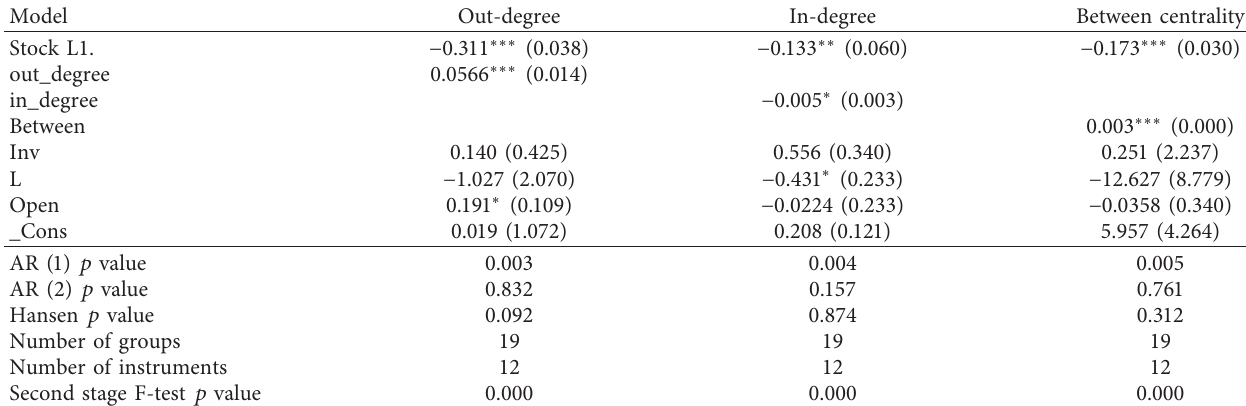
Table 5: Results of the impact of oil market structure on stock markets in Asian